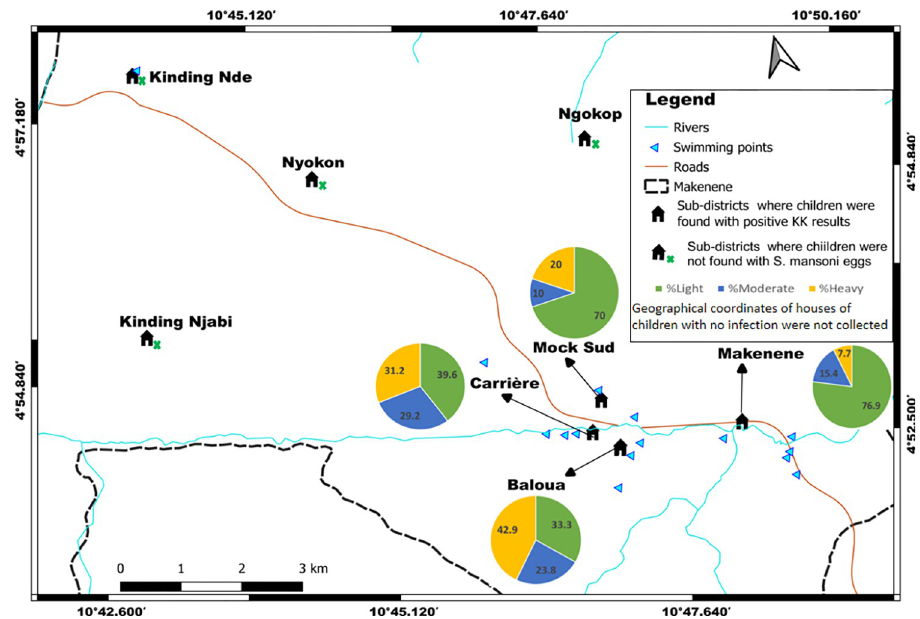
Fig 3. Sub-districts distribution of the percentage of children carrying different infection intensities inferred from Kato-Katz (base layer of the maps were obtained using a free online spatial data software (https://www.diva-gis.org/ gdata).